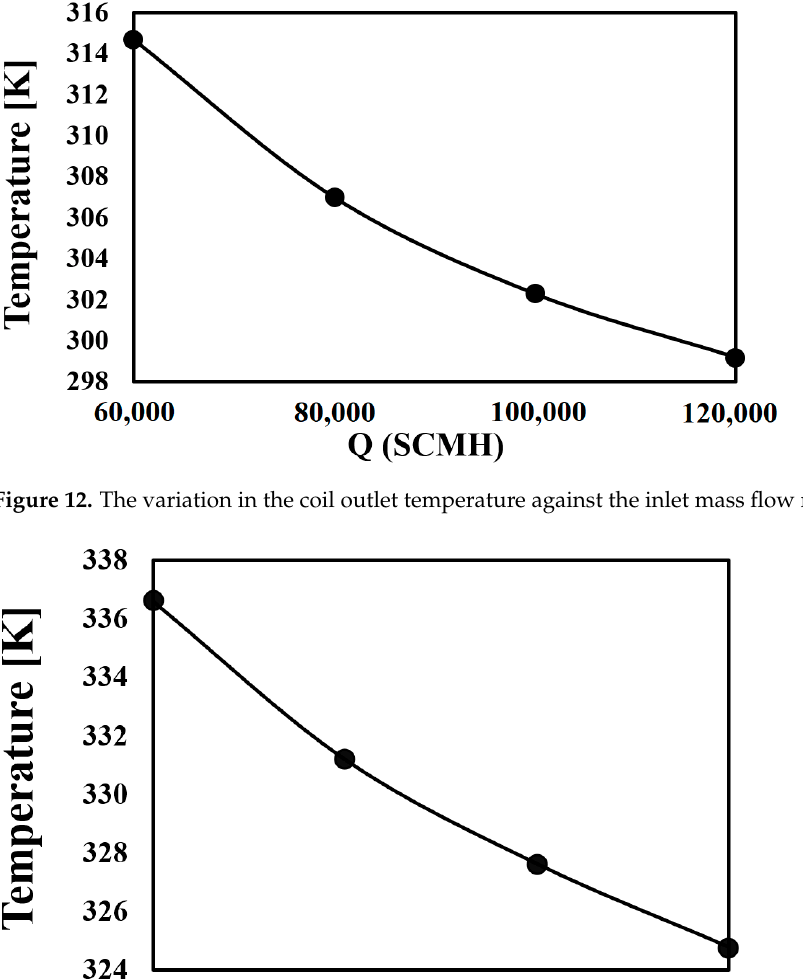
Figure 12. The variation in the coil outlet temperature against the inlet mass flow rate.